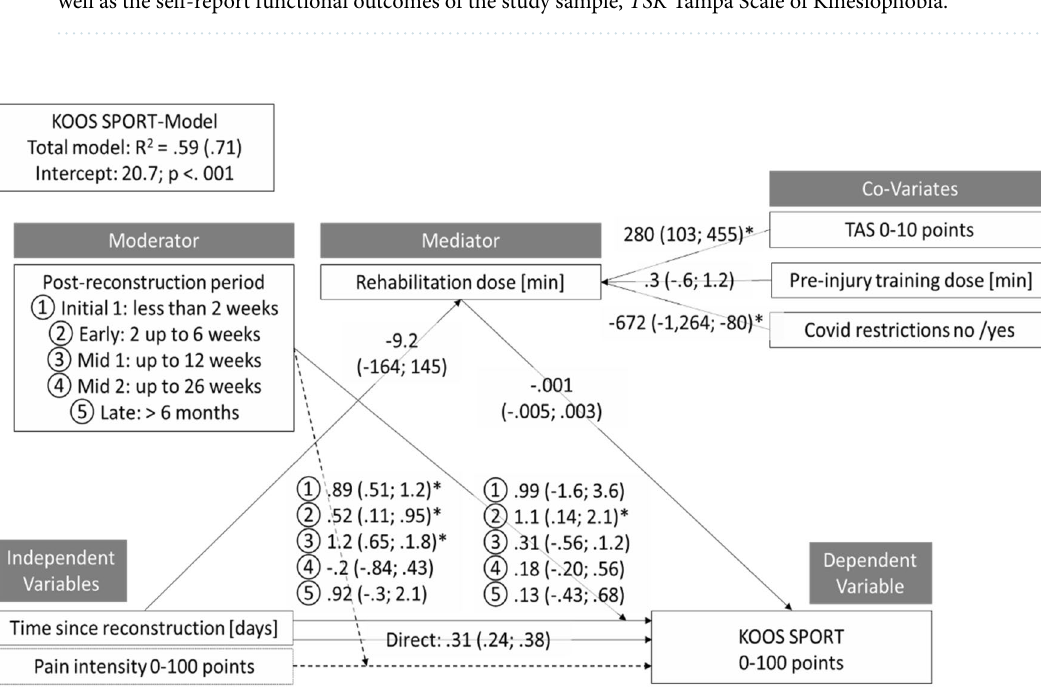
Figure 1. Moderated mediation model outcomes for the dependent variable KOOS SPORT. Coefficients and their confidence intervals (lower limit; upper limit) are displayed for direct, conditional direct, total and indirect effects of pain and time since reconstruction. The moderation effects of the different rehabilitation phases on the regression of pain intensity (left column) and time since reconstruction (right column) on KOOS SPORT are displayed, likewise. Asterisks (*) display a significant interaction. TAS Tegner activity scale, min minutes, R 2 variance explanation without (and, in brackets, variance explanation with) pain intensity as a